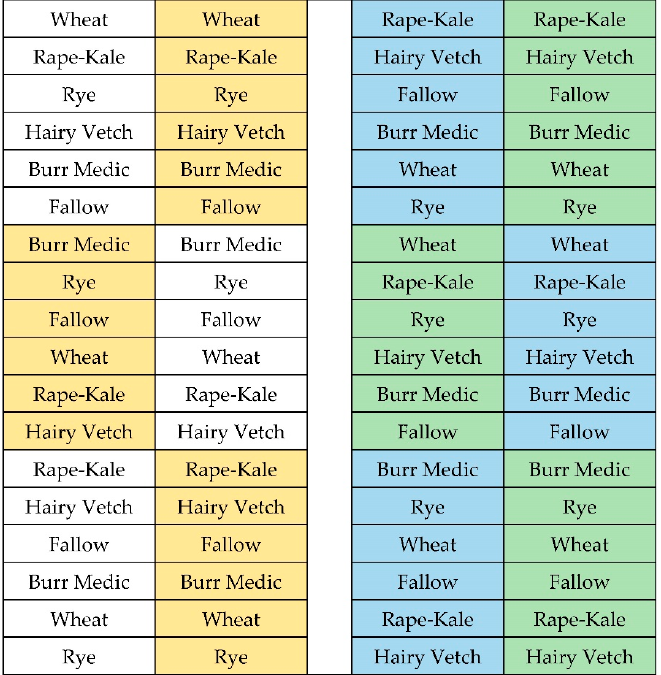
Figure 1. Orientation of treatments when winter cover crops were planted. Irrigation treatments were applied across all blocks (whole plot factor). Tillage treatments were randomly arranged east-west within whole plots (subplot factor). Cover crop treatments were applied perpendicular across subplots (sub-subplot factor). Color blocks represent treatment: white = dryland, no-till, yellow = dryland, minimum till, blue = irrigated, no-till, and green = irrigated, minimum till.